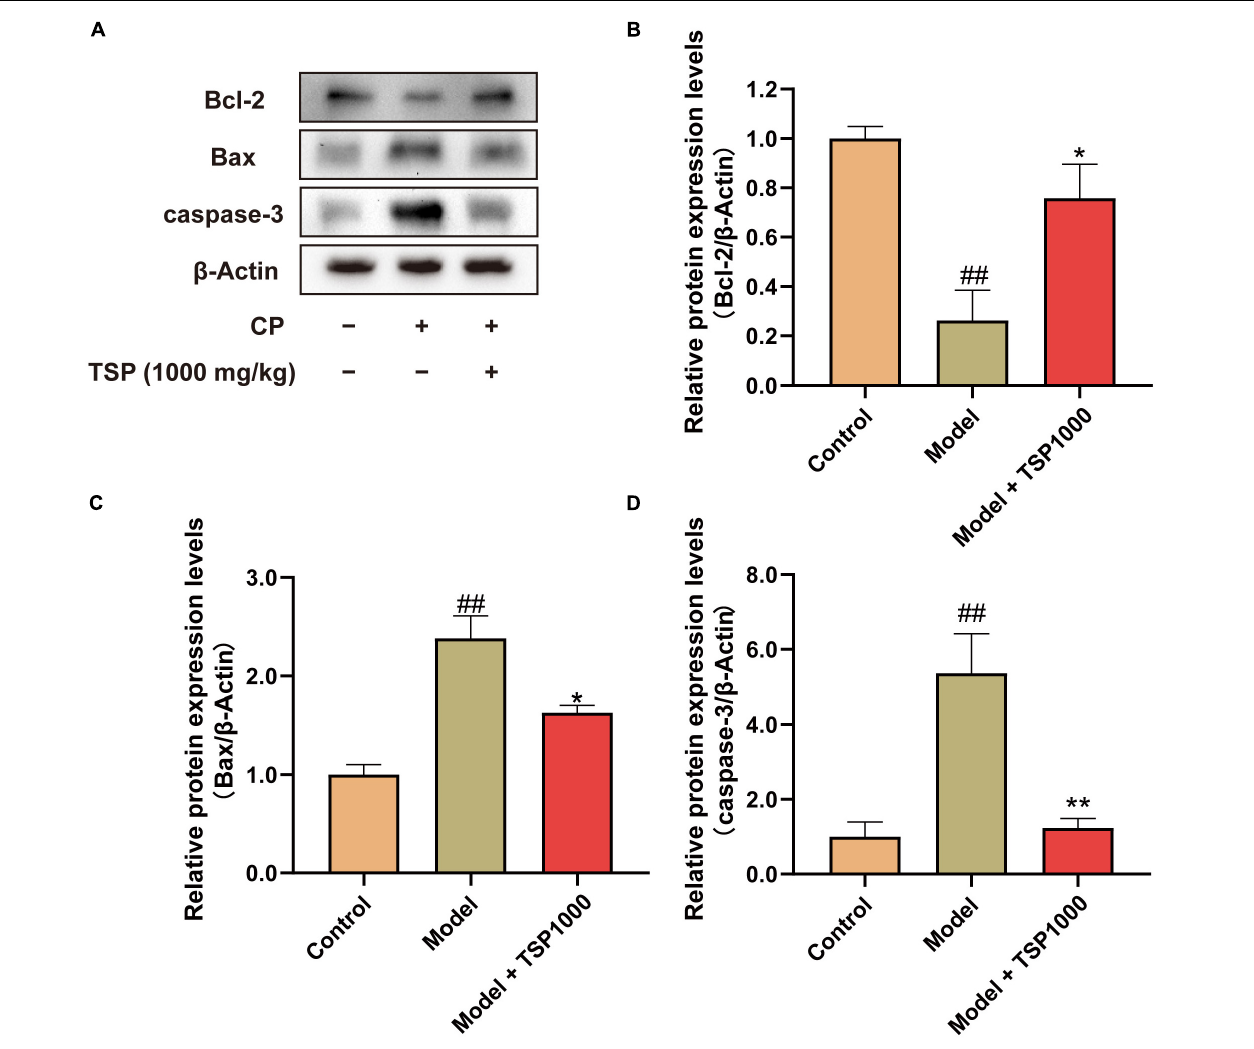
FIGURE 9 | The effects of TSP on the Bcl/Bax/caspase-3 apoptosis pathway. (A) The representative images of western blotting results. (B–D) Quantification of the protein expression of Bcl-2, Bax, and caspase-3. All data were expressed as mean ± SEM ( n = 3). ## P < 0.01 vs. Control group; * P < 0.05, ** P < 0 . 01 vs. Model